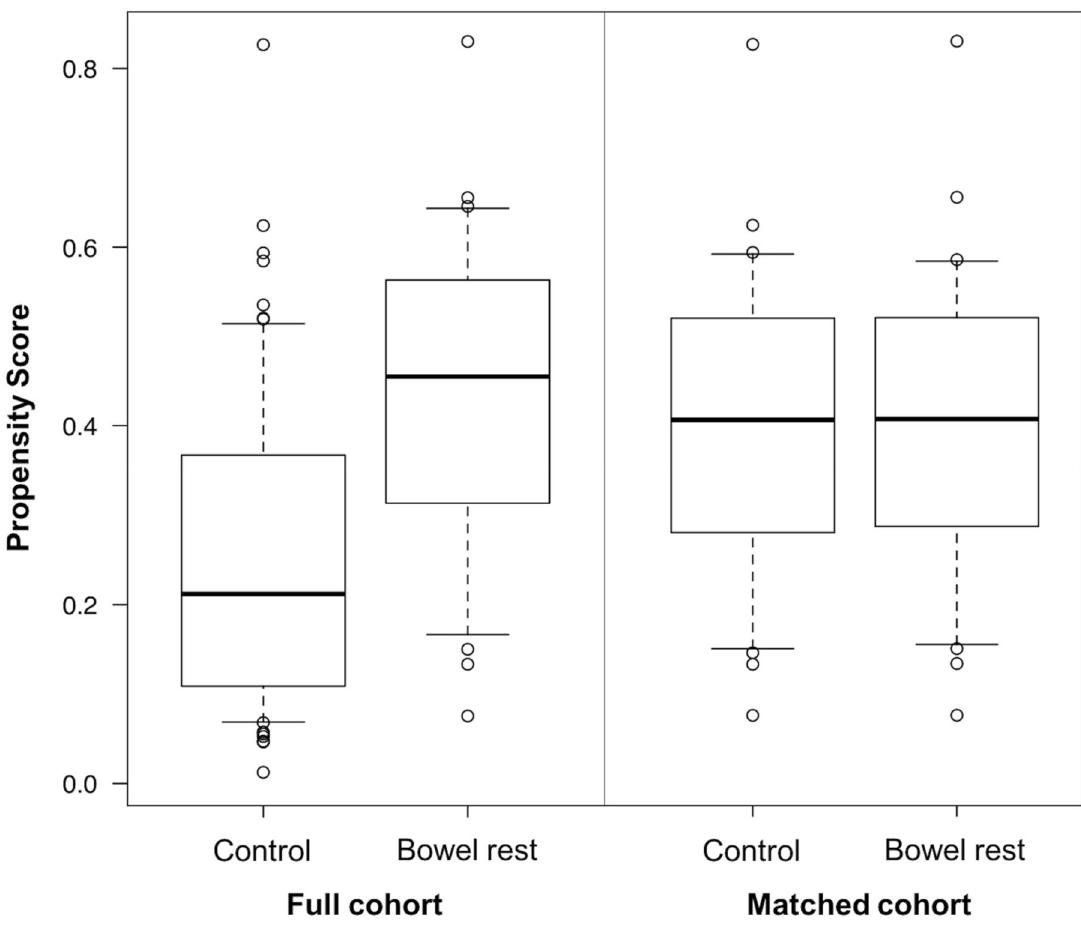
Figure 2. Side-by-side box plots before and after propensity score